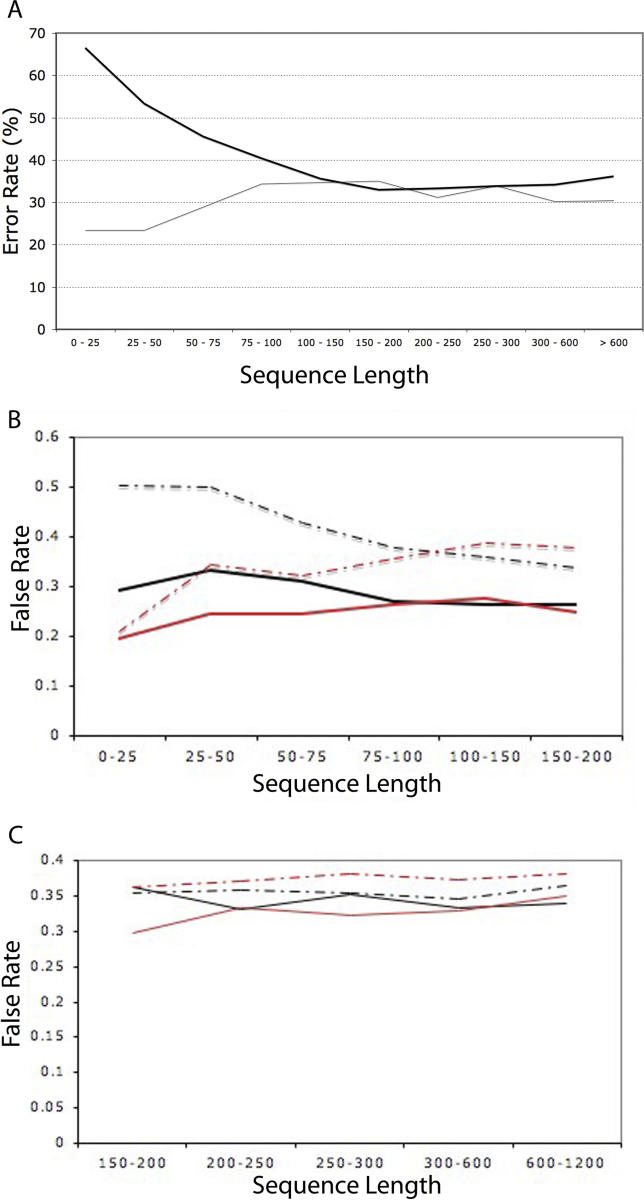
Predictor Performance Is a Function of Protein Length(A) Sequence effect on false-positive (thick line) and false-negative (thin line) error rate. Shorter sequences tend to have higher false positive identification of FFRs when trained on a nonpartitioned dataset.(B) Comparison of SVM prediction results trained on a nonpartitioned dataset (dashed lines) and a partitioned dataset containing proteins up to 200 residues (solid lines). Improvements were seen in both the false-positive (black) and -negative (red) rates.(C) Comparison of SVM prediction results trained on a nonpartitioned dataset (dashed lines) and a partitioned dataset containing proteins larger than 200 residues (solid lines). Minor improvements were observed in false-positive (black) and -negative (red) rates.